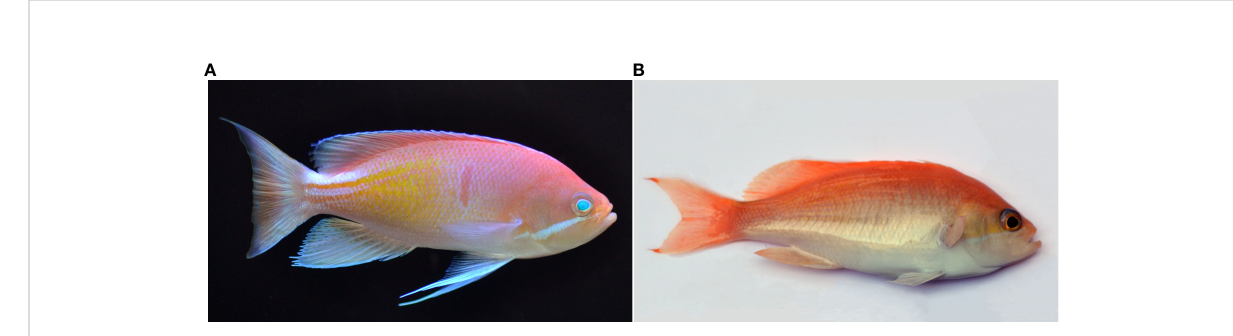
FIGURE 6 Pseudanthias marcia broodstock (A) male (B)